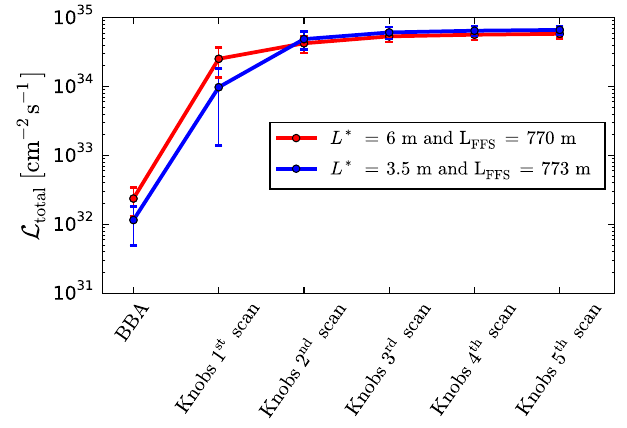
FIG. 25. Comparison of the average luminosity, over 100 machines simulated, achieved after BBA and iterations of linear knobs applied on the L (cid:1) ¼ 6 m design and the L (cid:1) ¼ 3 . 5 m design with L ¼ 770 m. Five scans of linear knobs FFS were applied, which represents approximately 2000 luminosity